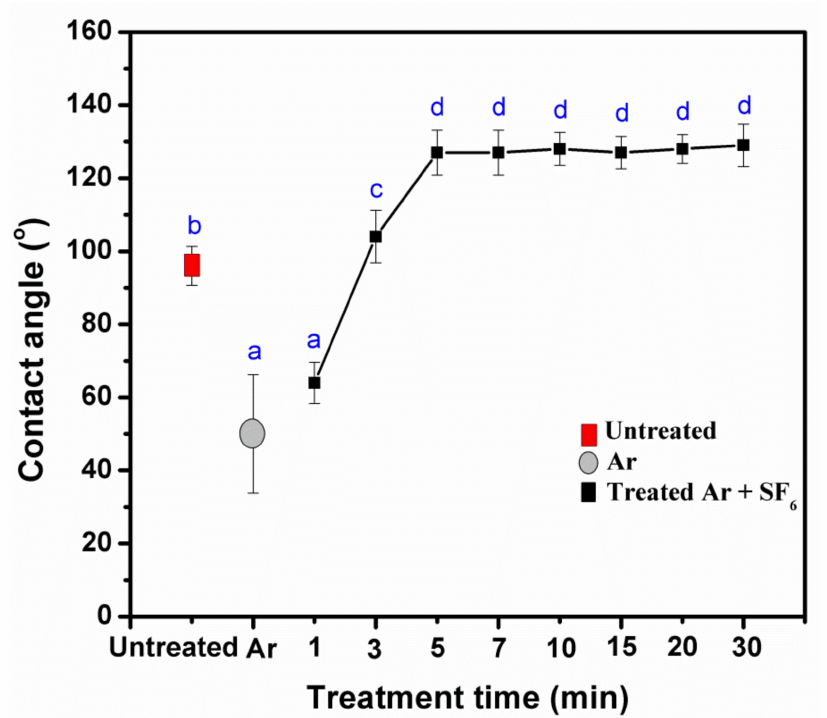
Figure 6. Effect of treatment time on the contact angles of untreated and treated KPs with plasma at 200 mTorr and 50 Watts. Note: values indicated with the same letters are not significantly different at p <